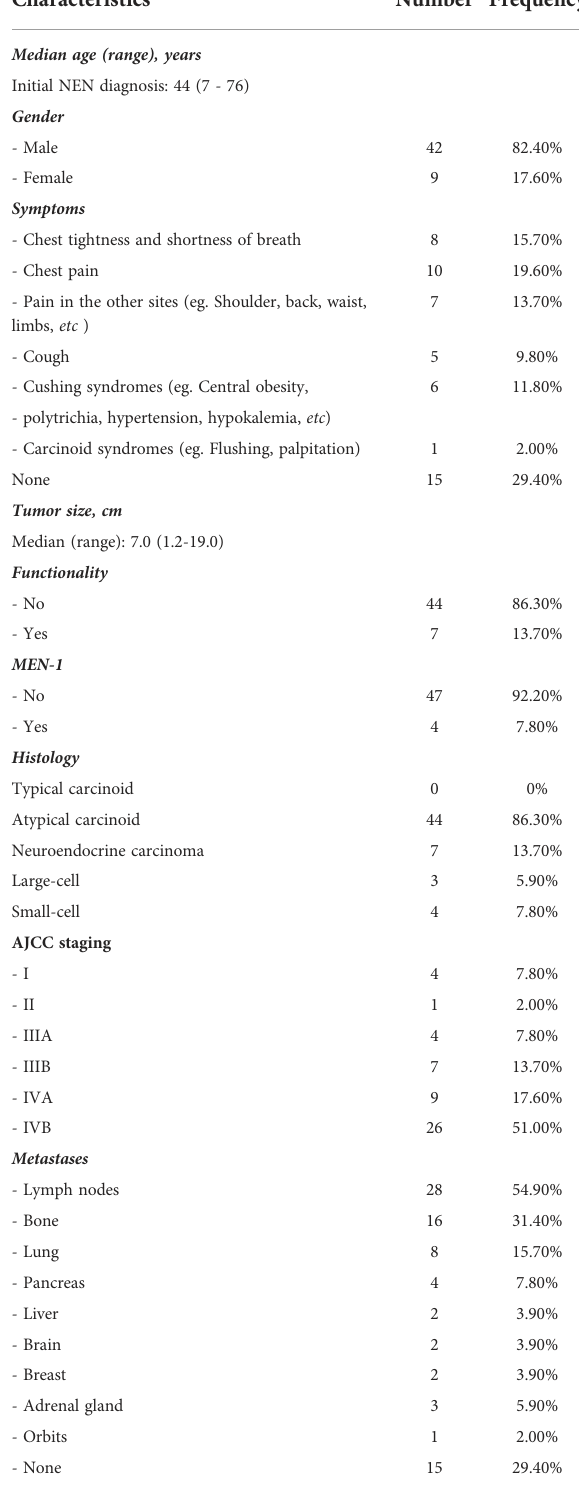
TABLE 1 Clinical characteristics of the patient